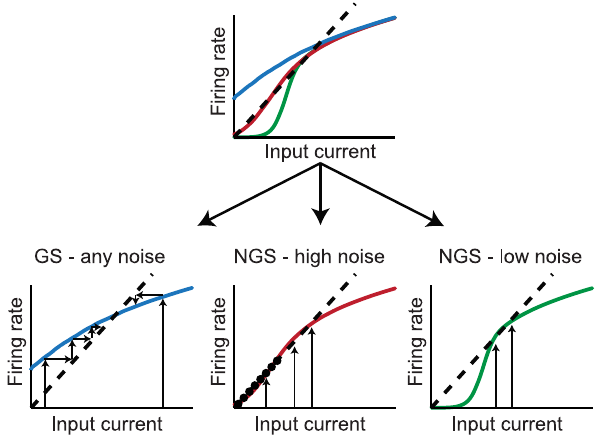
Figure 5. Fixed points of the iterated map dynamics. Top: An illustration of three f – I curves (colors) and the corresponding linear input-output relation (black dashed) with slope 1 = a derived from the mean field. Bottom left: The dynamics has a single stable fixed point and all input currents are attracted to it (indicated by small arrows converging to the fixed point). This corresponds to f – I curves of GS neurons at all values of s . Middle: The dynamics has a line of stable fixed points that allow robust transmission of a large range of input currents in the network. NGS neurons with high values of s have such dynamics. Right: The stable line of fixed points is smaller for f – I curves that are more "thresholding,’’ corresponding to NGS neurons with low s